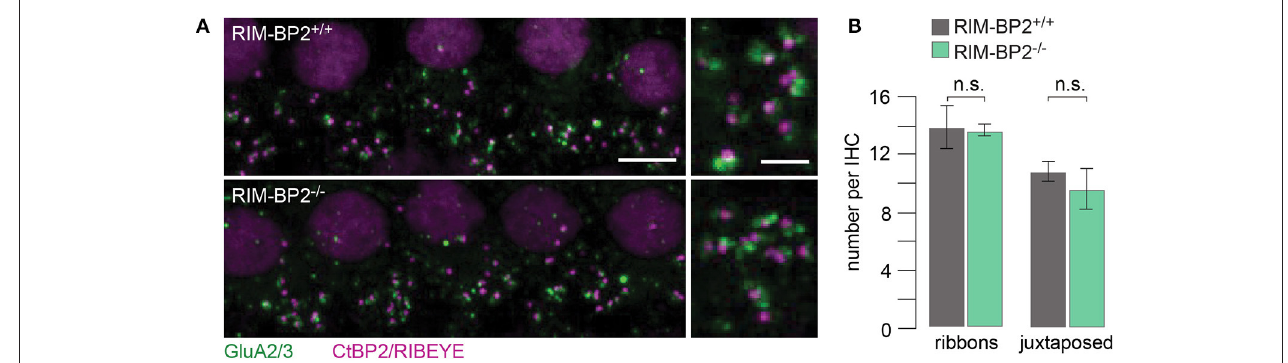
FIGURE 2 | RIM-BP2 disruption does not affect afferent IHC connectivity. (A) Left: Maximum projections of confocal stacks from whole-mount explants from apical organs of Corti of p21 mice, immunolabeled for CtBP2/RIBEYE (magenta) and GluA2/3 (green). Scale bar: 5 µ m. Right: Higher magnification shows details of synapses. Scale bar: 2 µ m; age of mice: p21. (B) 3D analysis of fluorescently labeled IHC ribbon synapses shows that the number of ribbons (CtBP2/RIBEYE spots, p = 0.9) and the number of ribbon-occupied synapses (number of juxtaposed RIBEYE/CtBP2 and GluA2/3 spots, p = 0.6) per IHC were not altered in RIM-BP2-deficient ( RIM-BP2 − / − , n = 38, N = 2) IHCs compared to control ( RIM-BP2 + / + , n = 56, N = 2) IHCs. Data represent grand averages, mean ± SEM; Wilcoxon rank test: significance level: n.s. p ≥ 0.05, n = number of IHCs, N = number of mice.